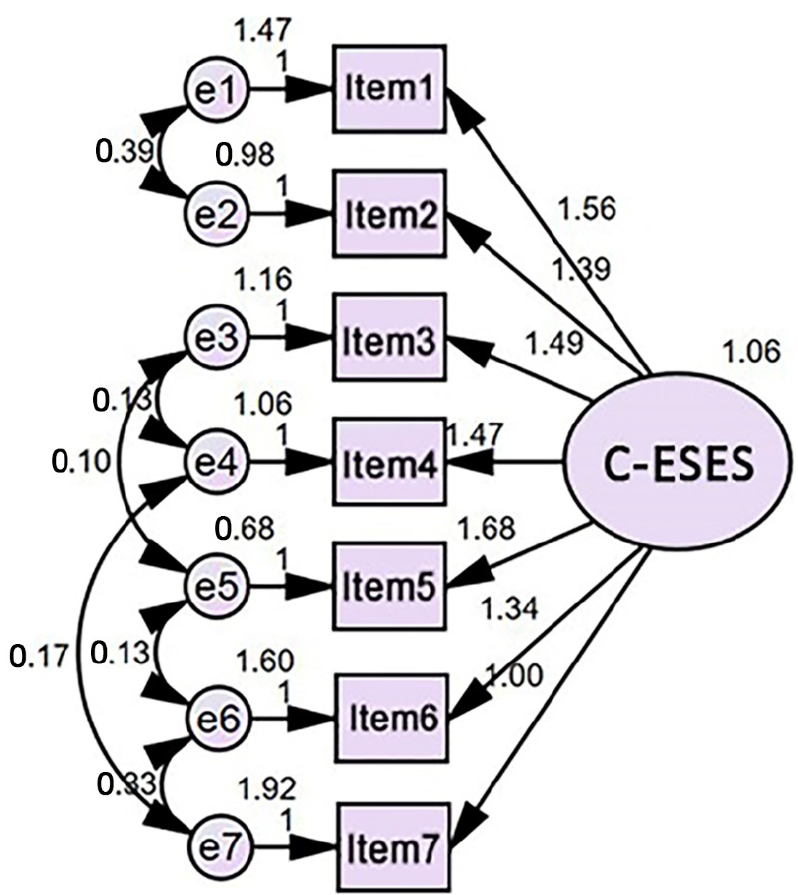
Figure 1. A statistical model for the emotional self-efficacy of Chinese respondents (C-ESES) based on the relationships among one latent variable (oval), seven measured items (rectangles), and seven corresponding unobservable errors